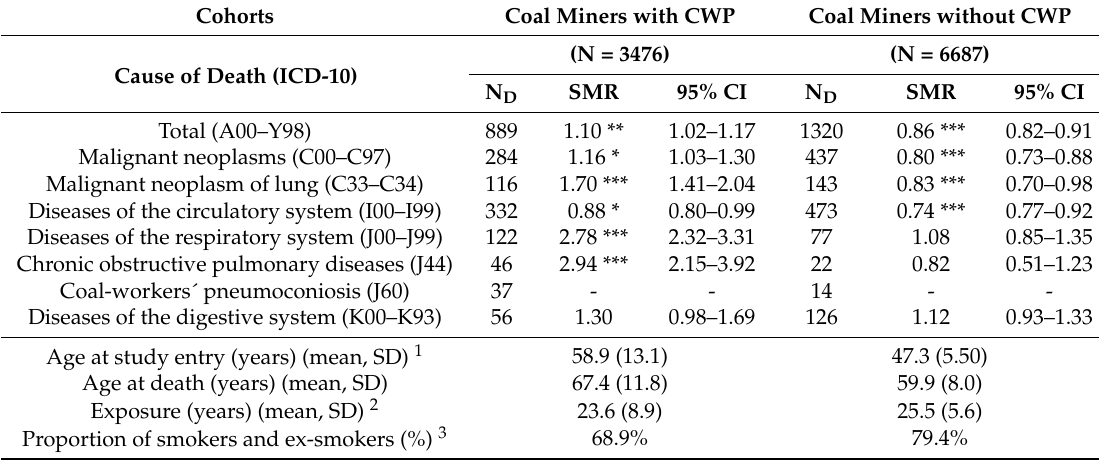
Table 3. The comparison of total and specific mortality in black coal miners with and without the acknowledged coal-workers´ pneumoconiosis (CWP), and mortality of the general male population in the Czech Republic in the period